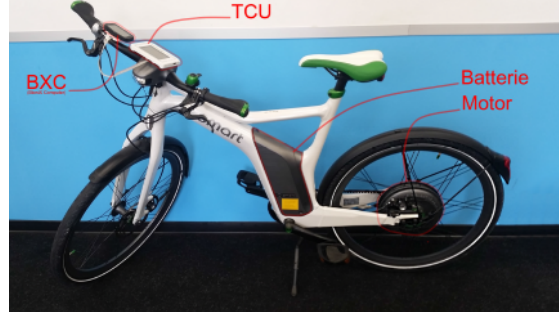
Figure 1: Pedelec with IoT